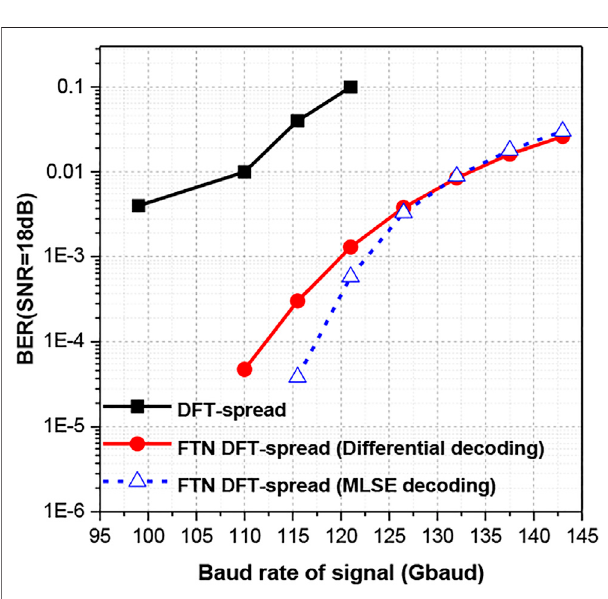
FIGURE 3 | BER versus baud rate of FTN-DFT-spread QPSK-OFDM in AWGN